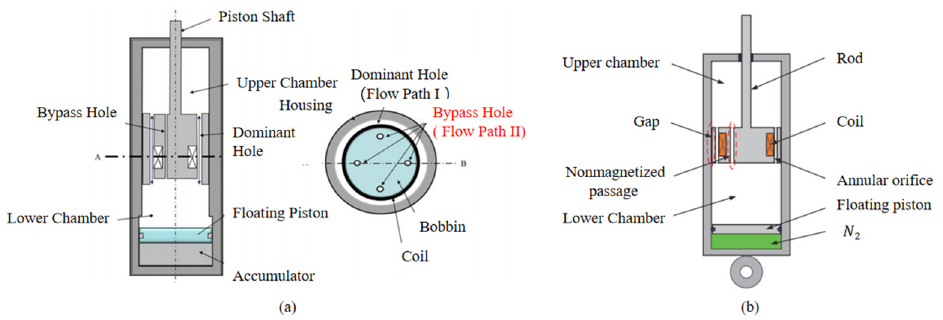
Figure 4. MRD with bypass hole (non-magnetized channel): ( a ) Piston with main fl ow path and four bypass holes [36]. ( b ) Piston with main fl ow path and two bypass holes [37]. bypass holes [36]. ( b ) Piston with main flow path and two bypass holes